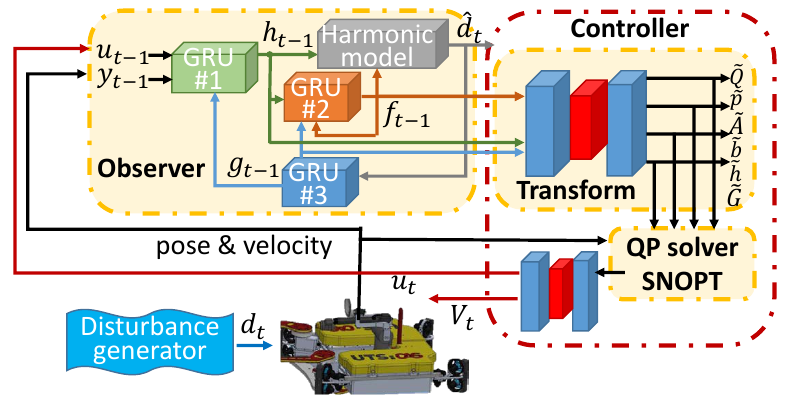
Figure 3. Network Architecture of